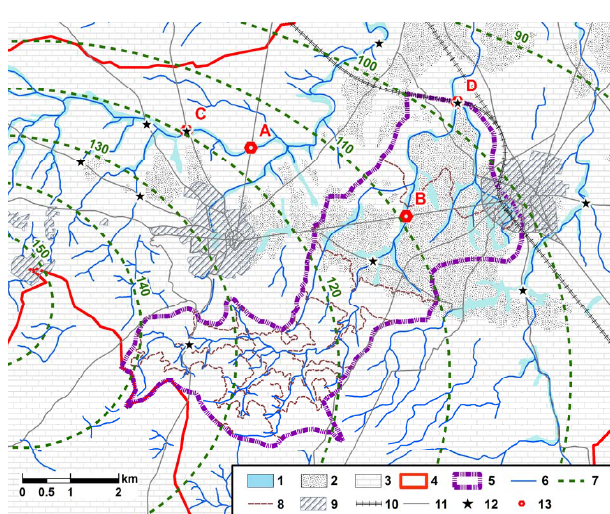
2 Figure 4 - Detailed map of selected sub-catchment: 1) Alluvial deposits, clay and silty clay 3 Fig. 4. Detailed map of selected sub-catchment: (1) alluvial de- with pebbles; 2) calcarenite, secondly sand and conglomerate; 3) limestone and dolostone; 4) 4 posits, clay and silty clay with pebbles; (2) calcarenite, secondly Picone Stream catchment divide; 5) selected sub-catchment (Scappagrano Stream); 6) 5 sand and conglomerate; (3) limestone and dolostone; (4) Picone drainage network; 7) Isohyet contours (mm) of total rainfall (from 2:30 AM on 22 October to 6 Stream catchment divide; (5) selected sub-catchment (Scappagrano 6:30 AM on 23 October); 8) isohypse (in the selected sub-basin); 9) urbanised areas; 10) 7 Stream); (6) drainage network; (7) Isohyet contours (mm) of to- railway; 11) road; 12) location of 2005 main damage; 13) location of relevant historical and 8 tal rainfall (from 02:30LT on 22 October to 6:30a.m. on 23 Octo- recent damages. 9 ber); (8) isohypse (in the selected sub-basin); (9) urbanised areas; (10) railway; (11) road; (12) location of 2005 main damage; (13) lo- cation of relevant historical and recent